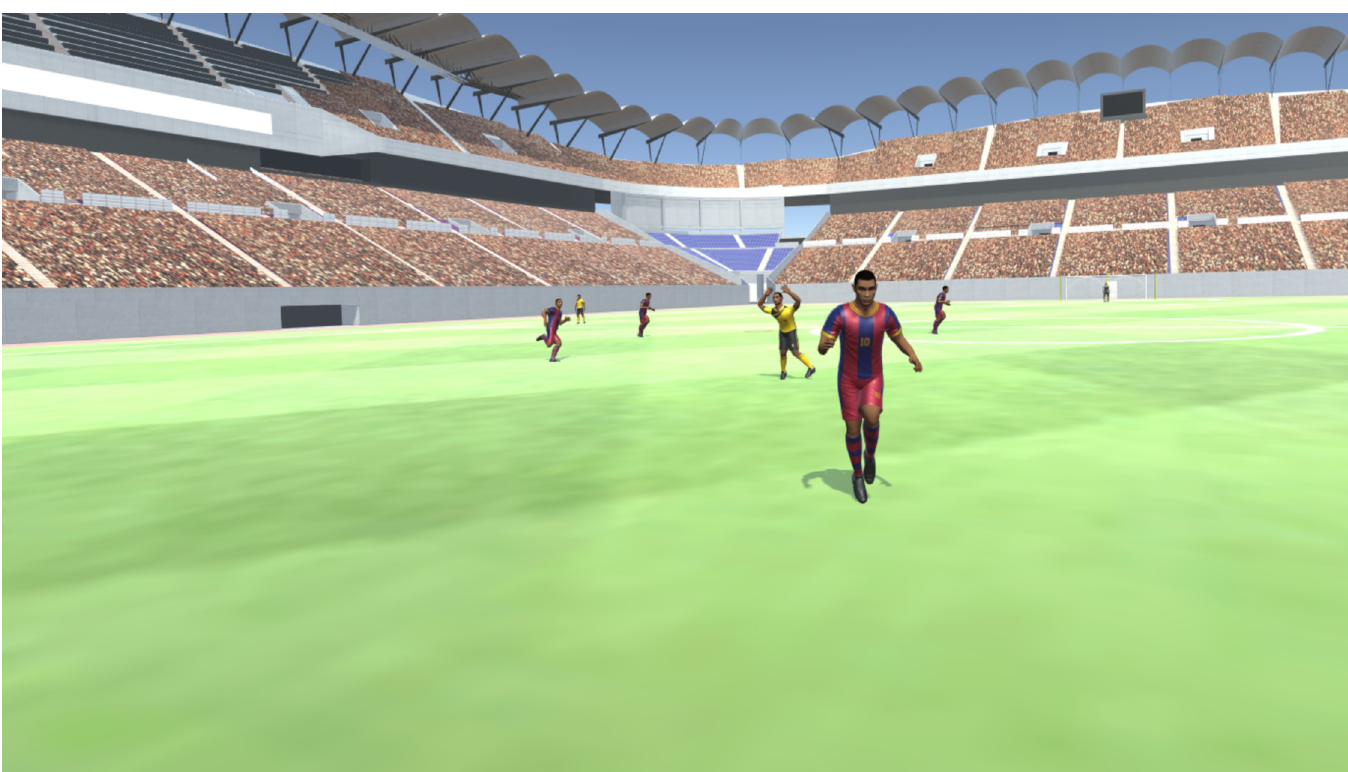
Fig 10. View of the “test”